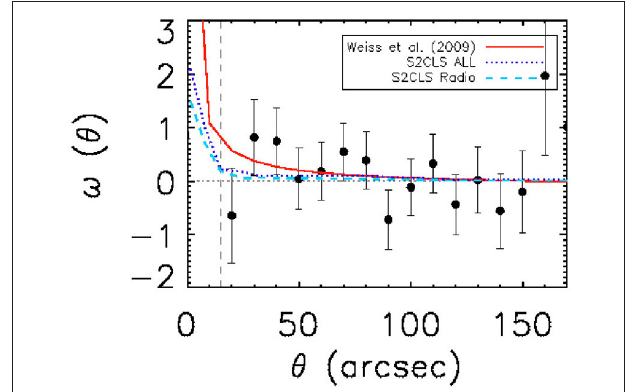
FIGURE 1 | Observed angular two-point correlation function using the Landy and Szalay (1993) equation, from Jones et al. (2017). The red solid curve shows the observed angular two-point correlation function for Weiß et al. (2009). The blue dotted line and cyan dashed line show the observed angular two-point correlation function for all the SMGs and the subset of radio-detected SMGs, respectively, in the S2CLS ( Wilkinson et al., 2017). Black points represent the observed angular two-point correlation function for the companion sources detected around WISE /radio AGNs. The dashed line represents the JCMT SCUBA-2 850 µ m beam size (15 arc s). There were not enough data for reliable and accurate results using the Hot